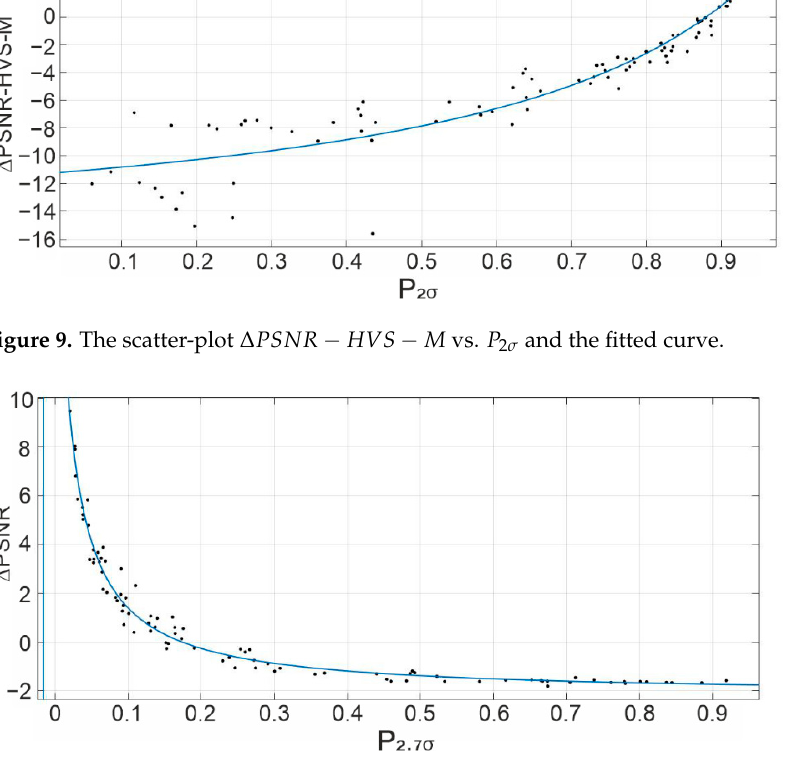
Figure 11. The scatter-plot ∆𝑃𝑆𝑁𝑅 − 𝐻𝑉𝑆 − 𝑀 vs. 𝑃 2.7𝜎 and the fitted curve. 4.2. Curve Fitting Details Having, in general, shown the possibility of a good curve fitting, we come to the next questions—what the best (appropriate) fitting is and how to characterize its accuracy. There are well developed theories of LMSE and robust fitting [46,47]. A visual analysis of the scatter-plots in Figures 7–10 shows that there are no obvious outliers in the data; thus, there is no obvious necessity to apply a robust fitting. LMSE regression is implemented in